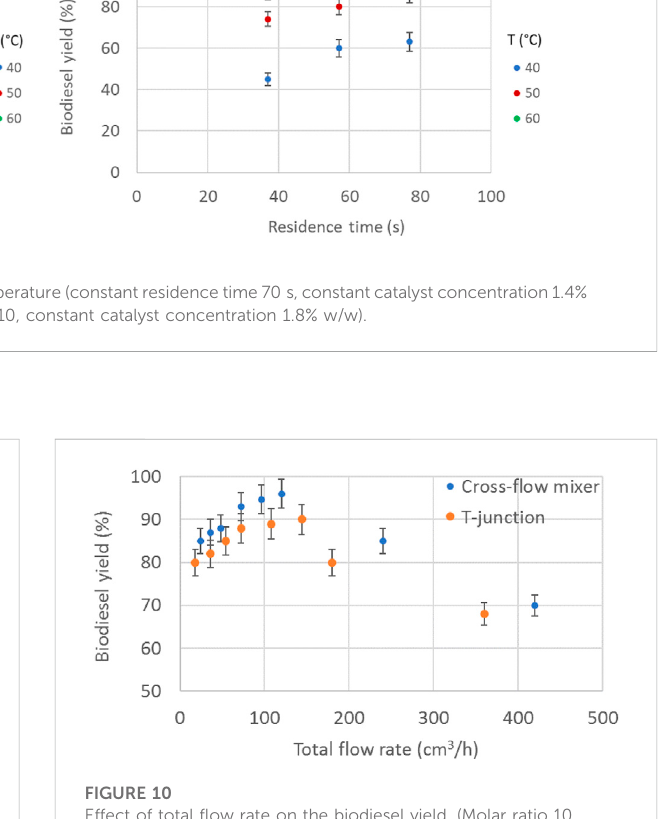
FIGURE 9 Biodiesel yield as a function of residence time and catalyst concentration. (Constant molar ratio 10, constant temperature 60 ° C).